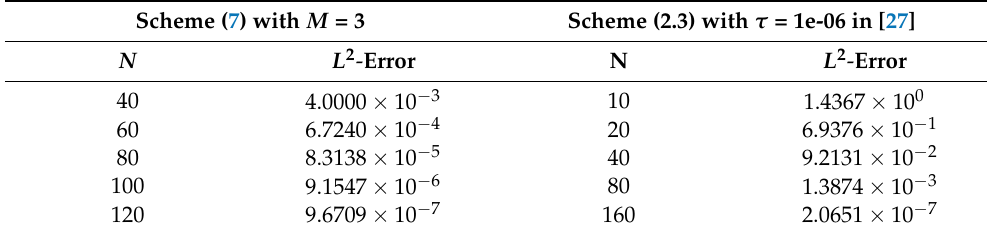
Table 3. Spatial errors at t = 1 for Example 2. Take a = − 40, b = 40, κ = 0.3, x 0 = 0.